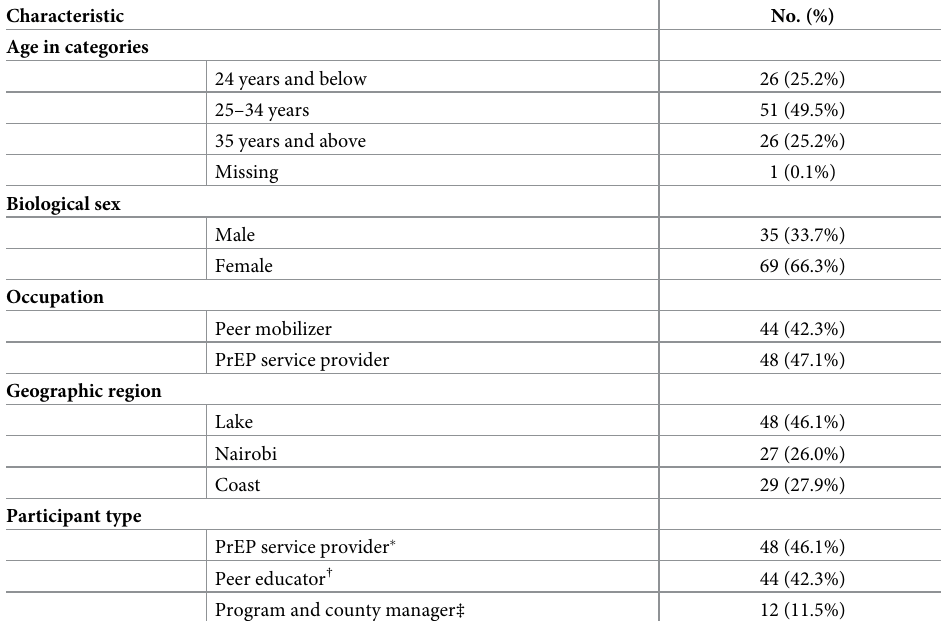
Table 2. Summary of participant demographic characteristics (n =